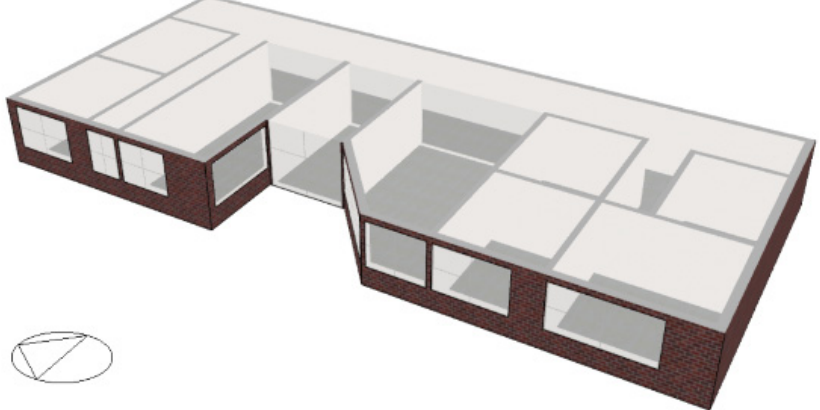
Figure 3. Baseline simulation model typical block bounded by the west façade (average WWR 51%).